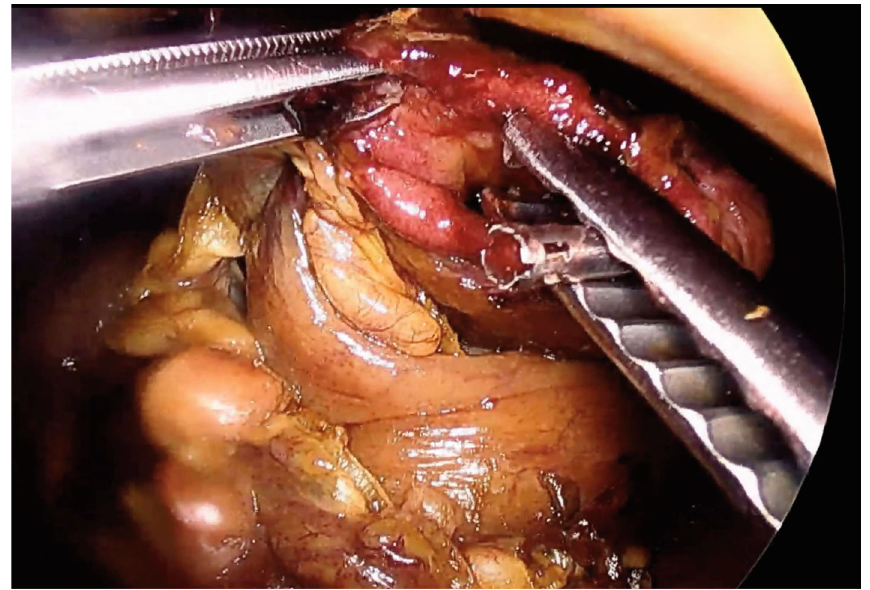
Figure 2: A still from the intraoperative video showing the perforation along the greater curvature of the